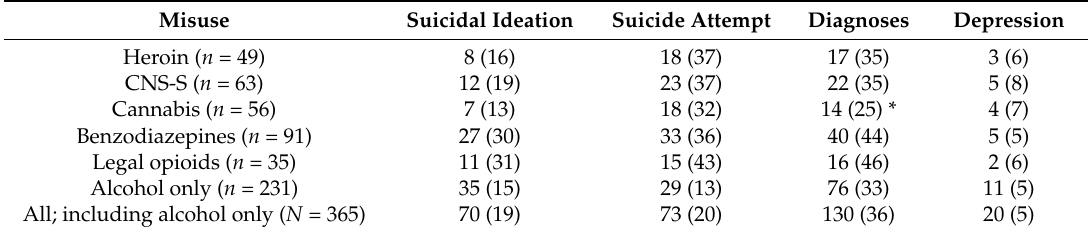
Table 1. Type of misuse related to suicidal behaviour and diagnoses in case